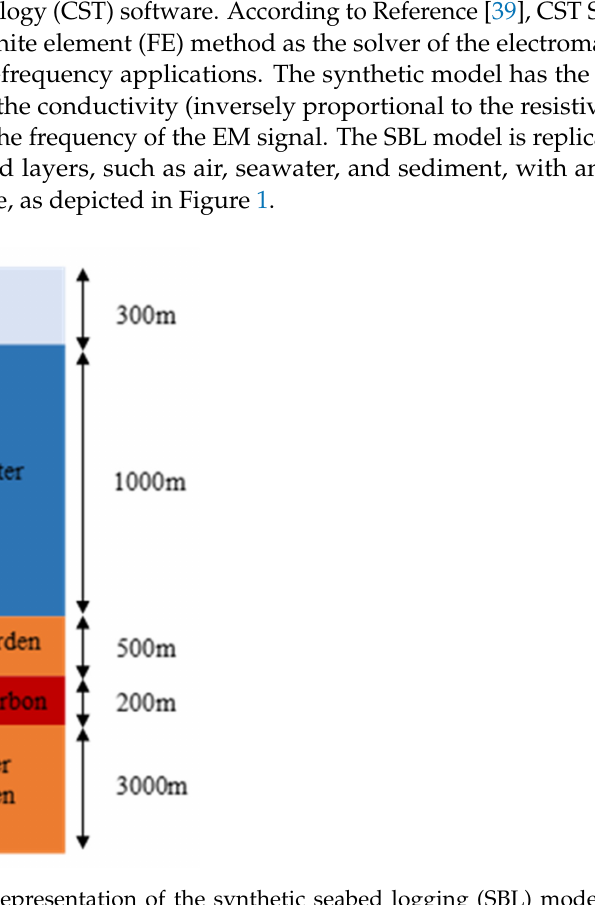
Figure 1. Representation of the synthetic seabed logging (SBL) model in the computer simula- tion technology (CST) software. The total height, width, and length are 5000 m, 20,000 m, and 20,000 m,